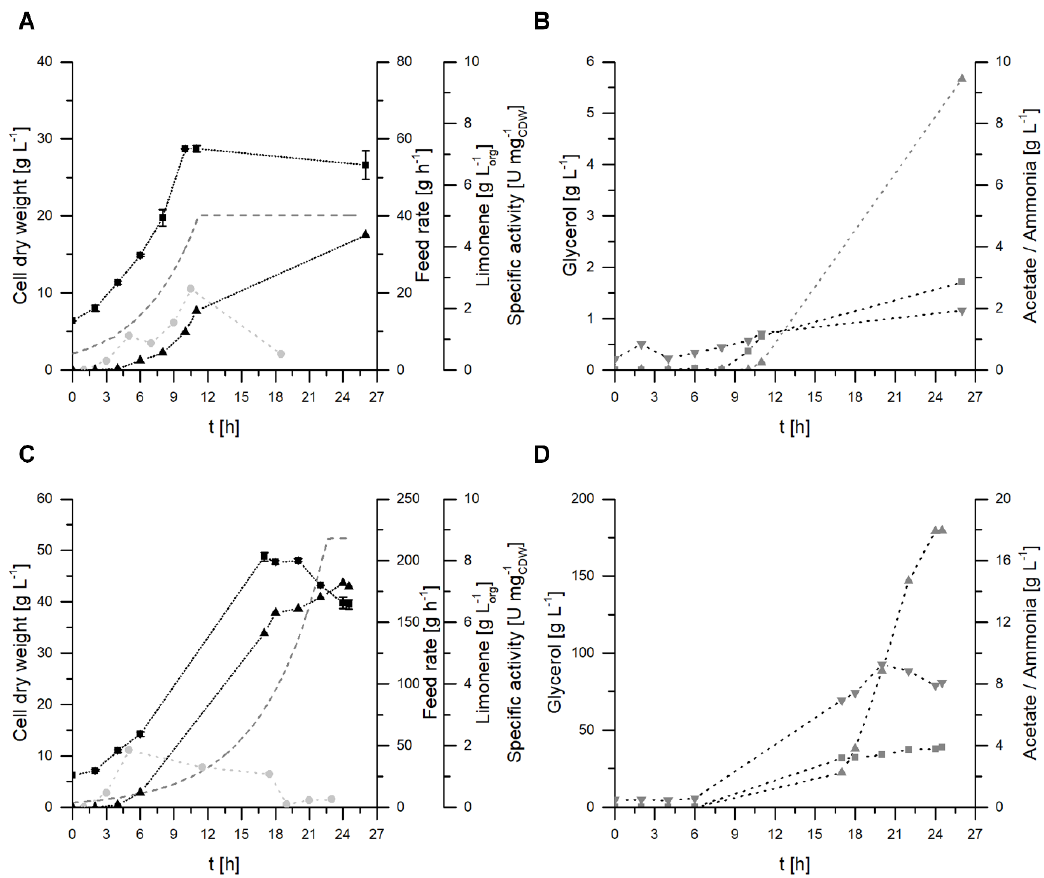
Figure 4. Two-liquid phase fed-batch fermentation with E. coli BL21 (DE3) pJBEI-6410 in M9 minimal medium. Cell dry weight (CDW) ( ■ ), limonene concentrations ( ▲ ) in the organic phase, glycerol ( ▲ ), acetate ( ▼ ), and ammonium ( ■ ) concentrations were determined at regular intervals. The specific activities ( ● ) were calculated for distinct time points throughout the fermentation time. The feed rate is displayed as well (dotted line). ( A) and ( B) display the initial fed-batch fermentation (D = 0.18 h − 1 ), whereas ( C ) and ( D ) display the optimized fed-batch fermentation with a lower feed rate (D = 0.15 h − 1 ) and additional trace element supply. The error bars for CDW relate to two independent measurements.